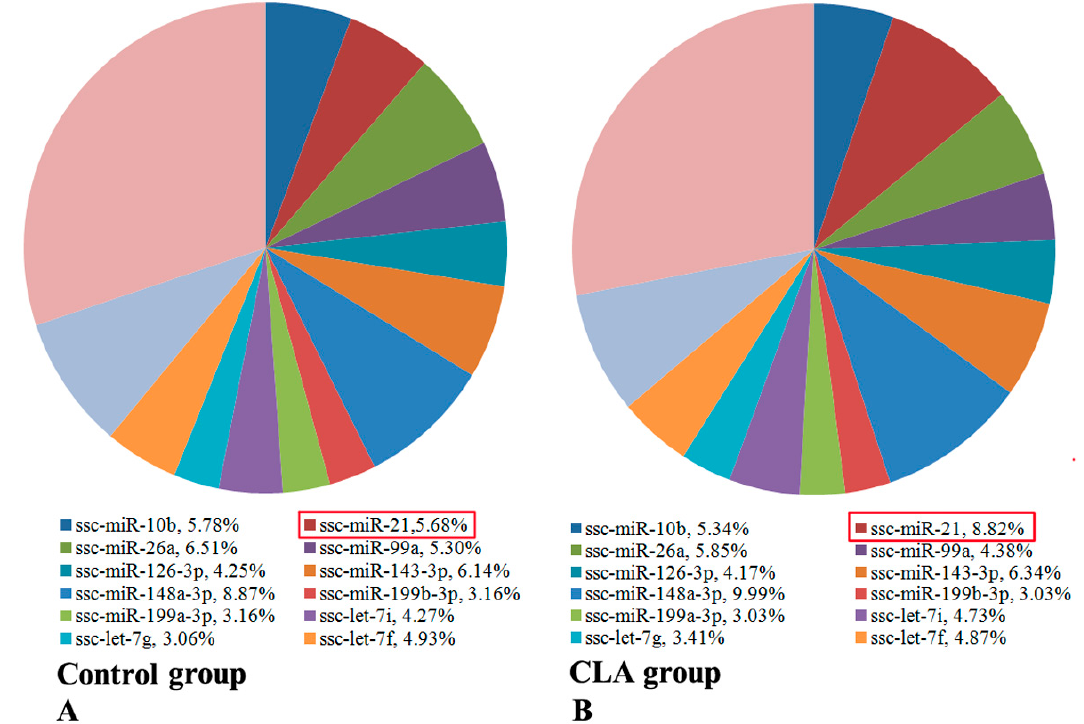
Figure 1. Thirteen known miRNAs highly expressed in both subcutaneous and abdominal adipose tissues from deep sequencing. ( A ) The read counts of miRNAs were collected at each period of subcutaneous adipose tissues and at day 240 of abdominal adipose tissues from the control group; ( B ) The read counts of miRNAs were collected at each period of subcutaneous adipose tissues and at day 240 of abdominal adipose tissues from the conjugated linoleic acid (CLA) treatment group.